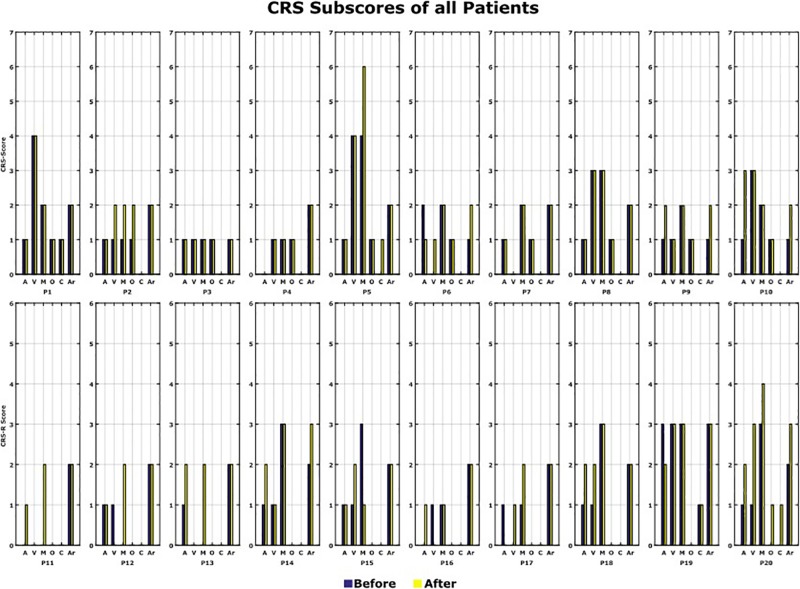
CRS-R scores. All the CRS-R subscores before and after the BCI rehabilitation therapy are shown. A, auditory function; V, visual function; M, motor function; O, oromotor/verbal function; C, communication; Ar, arousal.